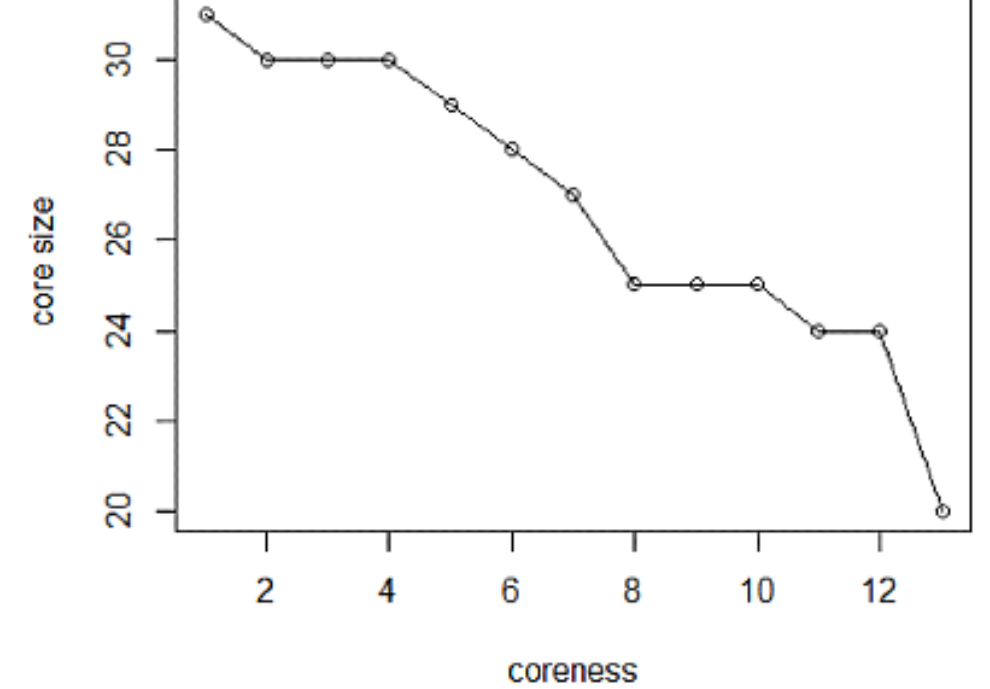
Figure 6. Plot of the core size versus the coreness of the network nodes over the whole study period. The core size represented in the vertical axis indicates the number of nodes with corenesses greater than or equal to the corresponding coreness on the horizontal